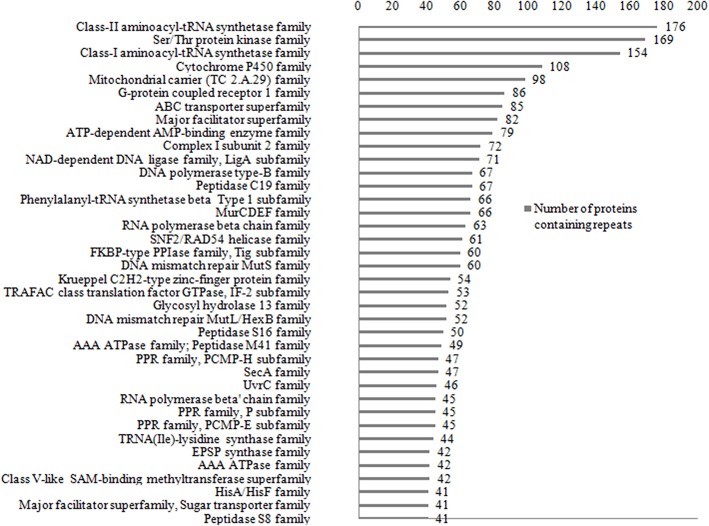
List of the 36 protein families that are having long repeats in more than 40 member proteins.